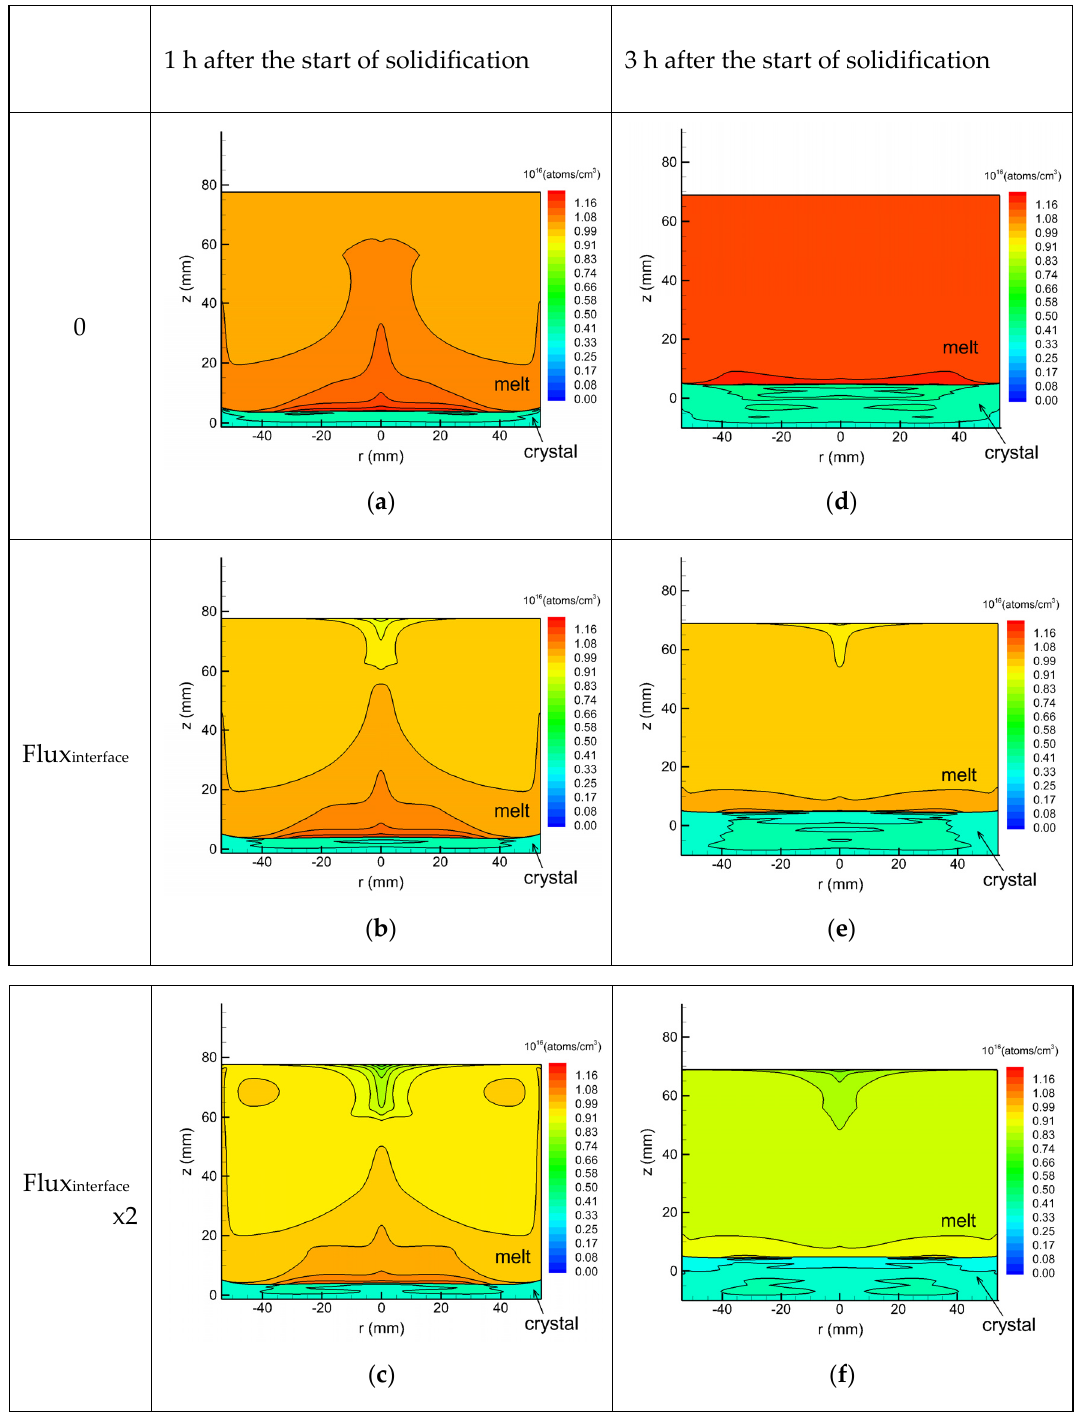
Figure 8. Distribution of the phosphorus concentration in the melt with different evaporation fluxes at the melt surface after one hour and three hours of solidification. The phosphorous evaporation flux at the melt surface was (i) 0 ( a , d ), (ii) the same as the phosphorus incorporation flux at the melt–crystal interface ( b , e ), and (iii) twice as large as that of case (ii) ( c , f ).